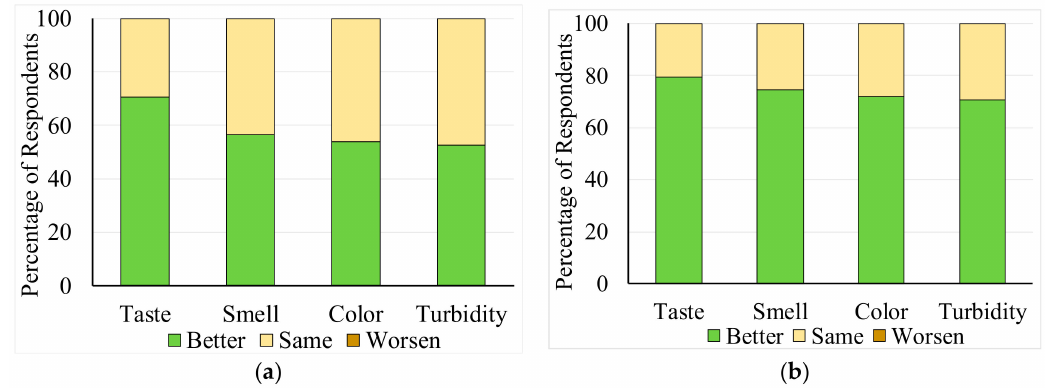
Figure 4. Relative quality perception of LCD water compared with: ( a ) previous main source and ( b ) social-club